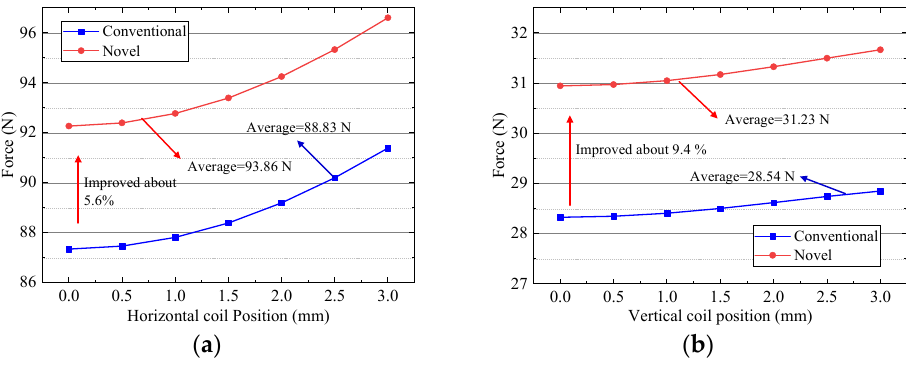
Figure 16. Driving force versus position in y direction: ( a ) Horizontal coil; ( b ) Vertical coil. The change of effective length of the winding in the inhomogeneous magnetic field results in the fluctuation of the driving force. The ripple ratio, η , is introduced to evaluate fluctuation of driving force with the movement of the coil, as follow: